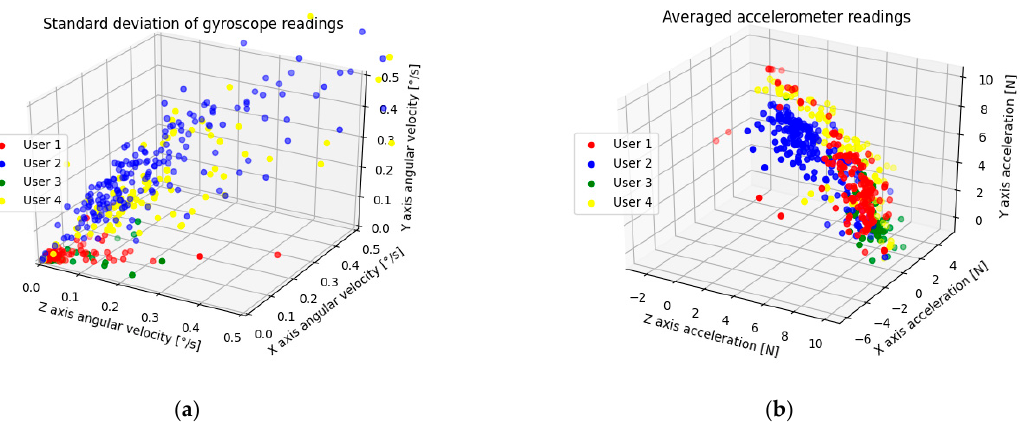
Figure 3. Exemplary user data on average accelerometer readings ( a ) and standard deviation of gyroscope readings ( b ) from 20-second